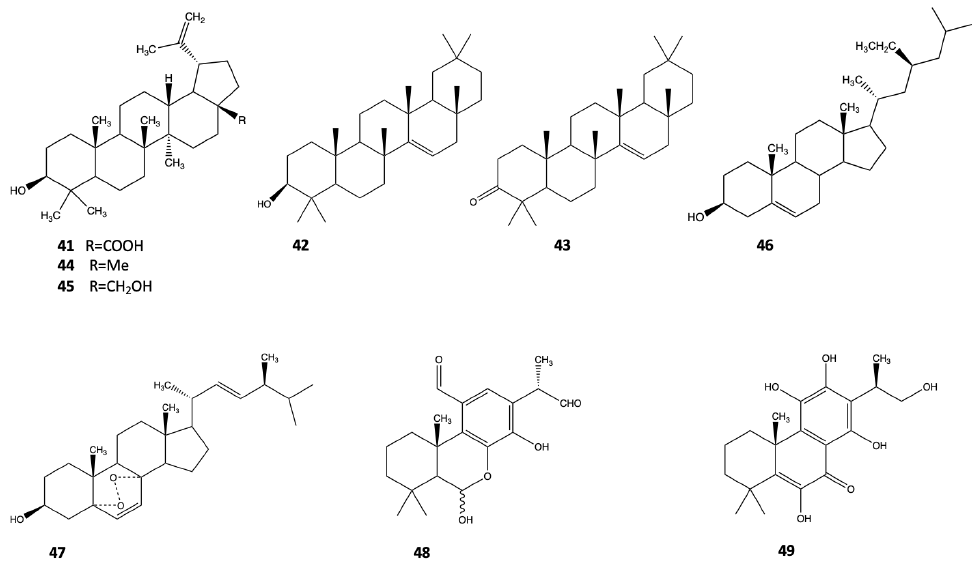
Figure 5. Terpenoids from A. marina.